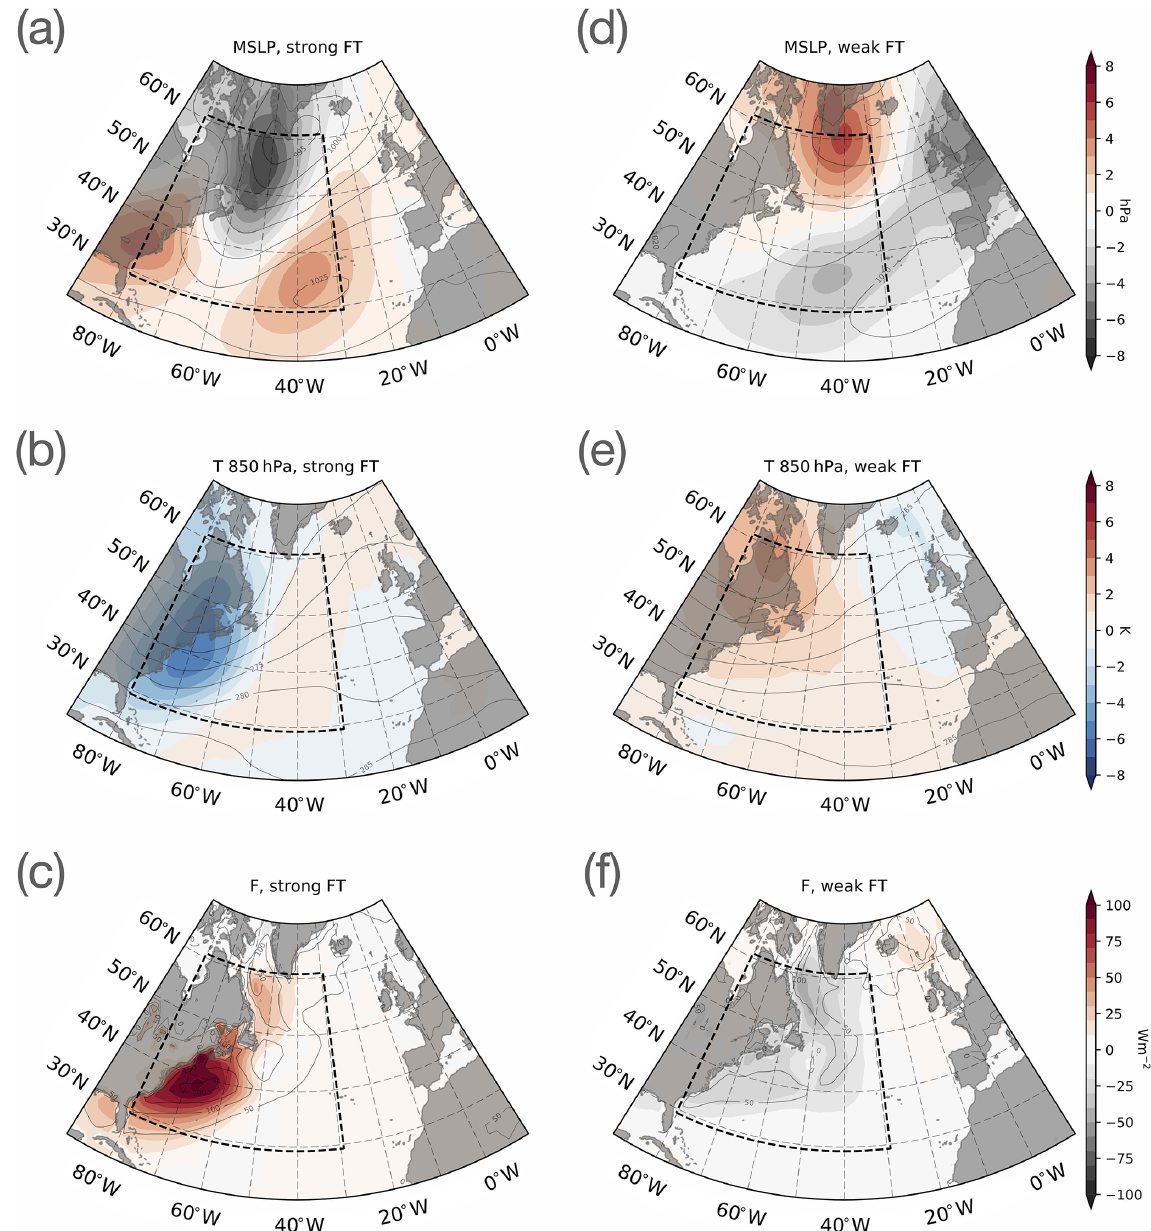
Figure 3. Composites of strongest (a–c) and weakest (d–f) FT index values (top and bottom 5th percentiles) for mean sea level pres- sure (a, d) , air temperature at 850hPa (b, e) and surface sensible heat flux (c, f) . Contours and colour shadings represent composites and their difference from winter climatology, respectively; dashed boxes indicate the spatial domain where the FT index is